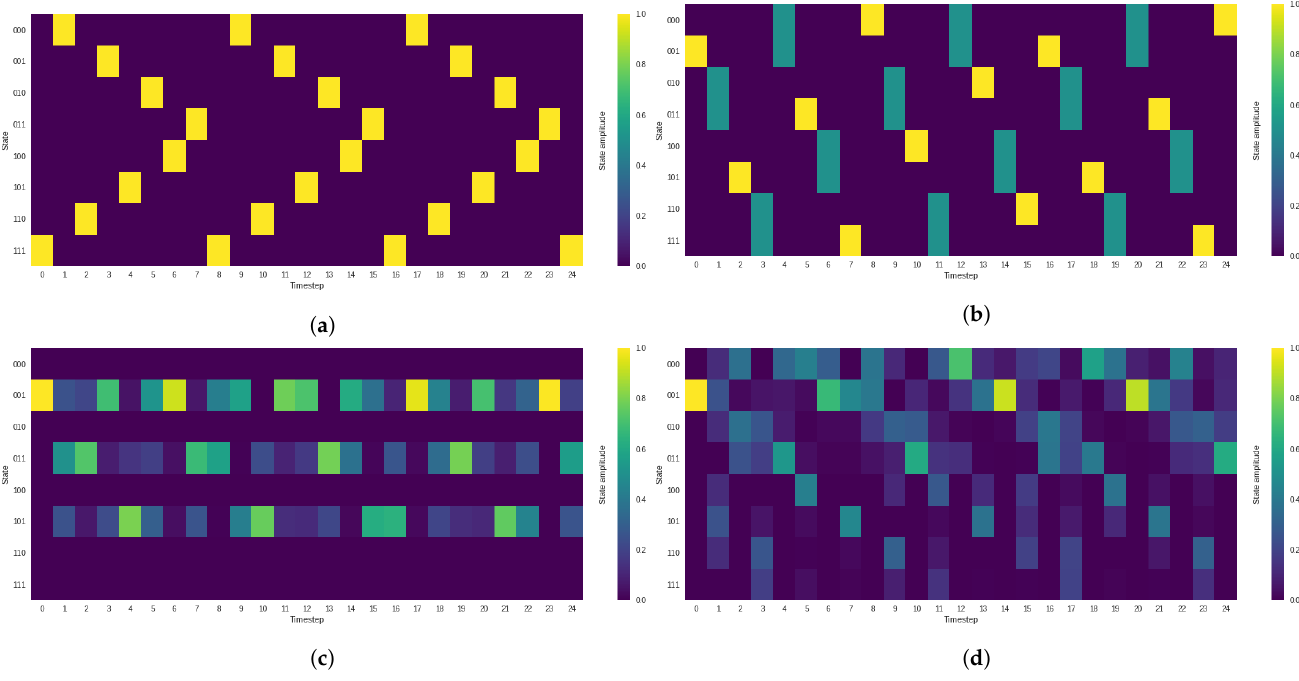
Figure 2. Examples of different dynamics exhibited by a quantum Boolean network (QBN) with 3 nodes. In panel ( a ), we observe a dynamic that keeps the amplitude concentrated in one particular state, such dynamic resemblances the behavior of a reversible Boolean network. Panels ( b – d ) illustrate some of the dynamics that can be observed in